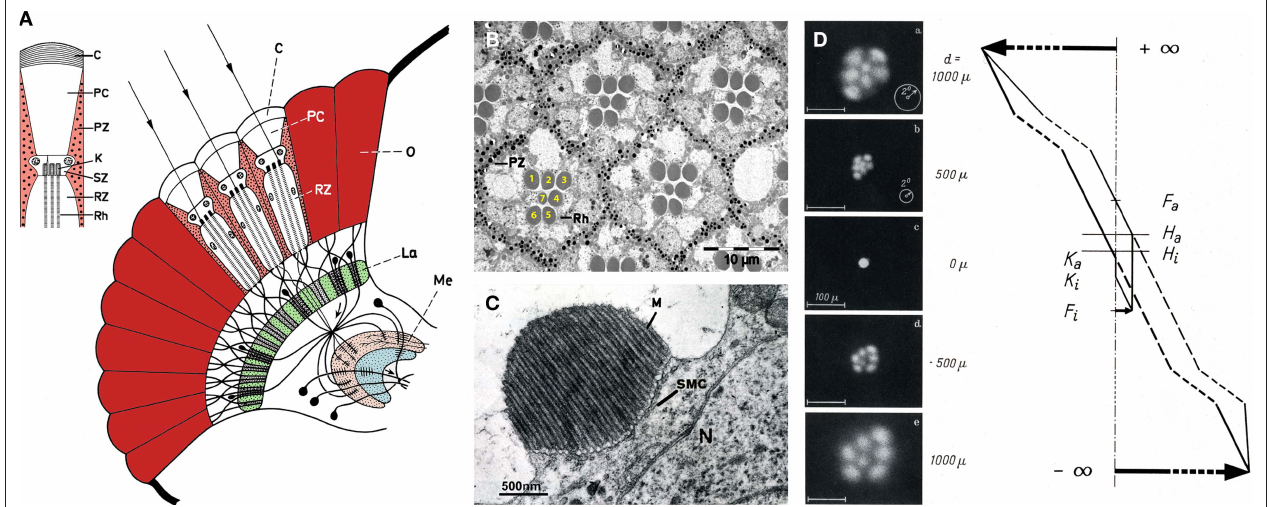
FIGURE 1 | The morphology and optics of the compound eye. (A) The compound eye of Musca and the visual ganglionic layers: a schematic representation of a horizontal section. Inset – Schematic representation of the distal area of a single ommatidium. C – corneal lens, PC – pseudocone, RZ – retinula cells (photoreceptor), PZ – pigment cells, K – rhabdomere cap, SZ – Semper cells, Rh – rhabdomere, La – lamina, Me – medulla (modifi ed from Kirschfeld, 1967). (B,C) Electron microscopic (EM) cross-section of Drosophila ommatidia and a rhabdomere at the upper region of the